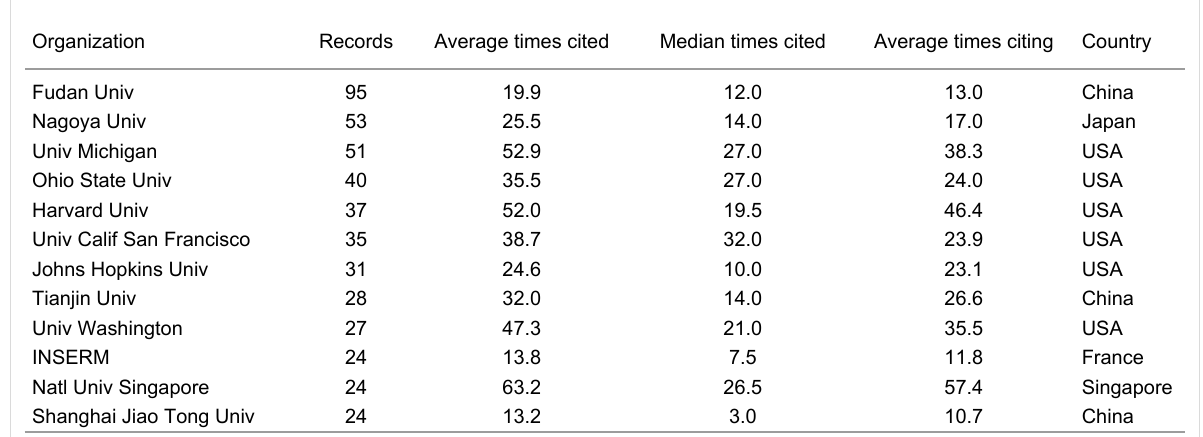
Table 3: Publications and citation information for the top 12 institutions. a